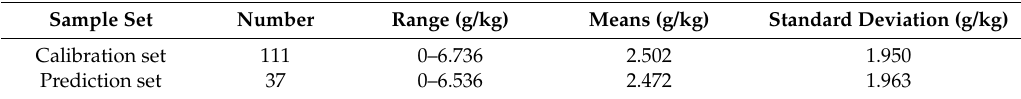
Table 1. Statistical analysis of SO 2 residual content in the calibration set and the prediction set.